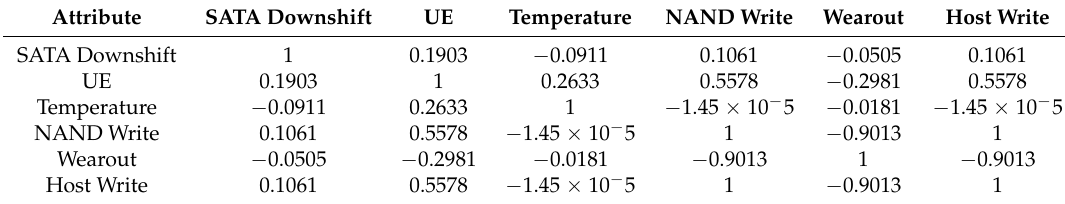
Table 9. Spearman Correlation Coefficient.